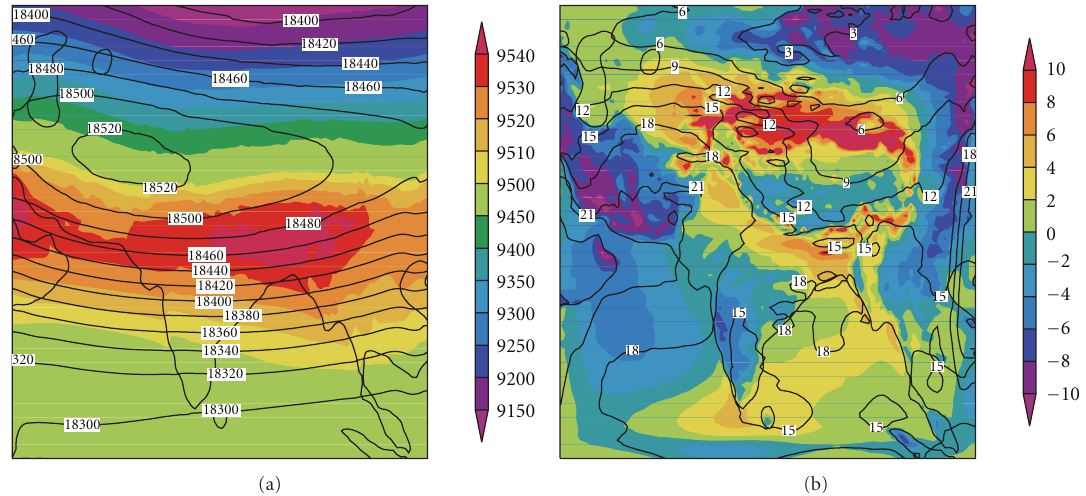
Figure 4: Geopotential height at 300 hPa (gpm; shaded) and geopotential height at 70hPa (gpm; contour lines) for HIRHAM (a) and the di ff erence “HIRHAM-ERA40” (b); summer monsoon (JJAS) 1958–2001.